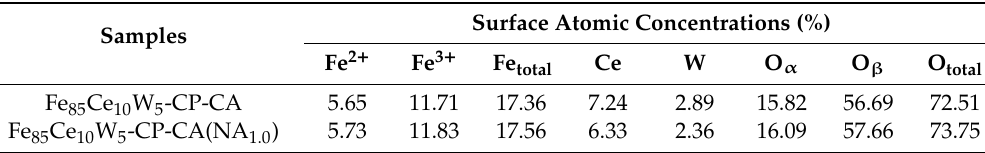
Table 3. The X-ray photoelectron spectroscopy (XPS) results of catalysts.